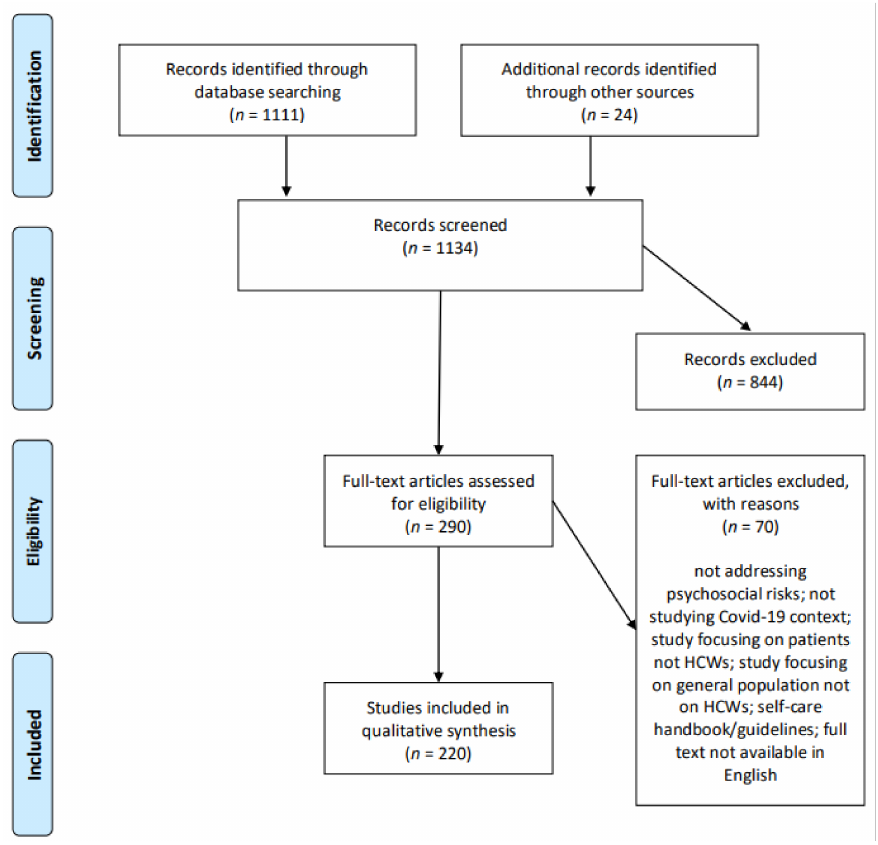
Figure 1. PRISMA flow diagram of the study selection